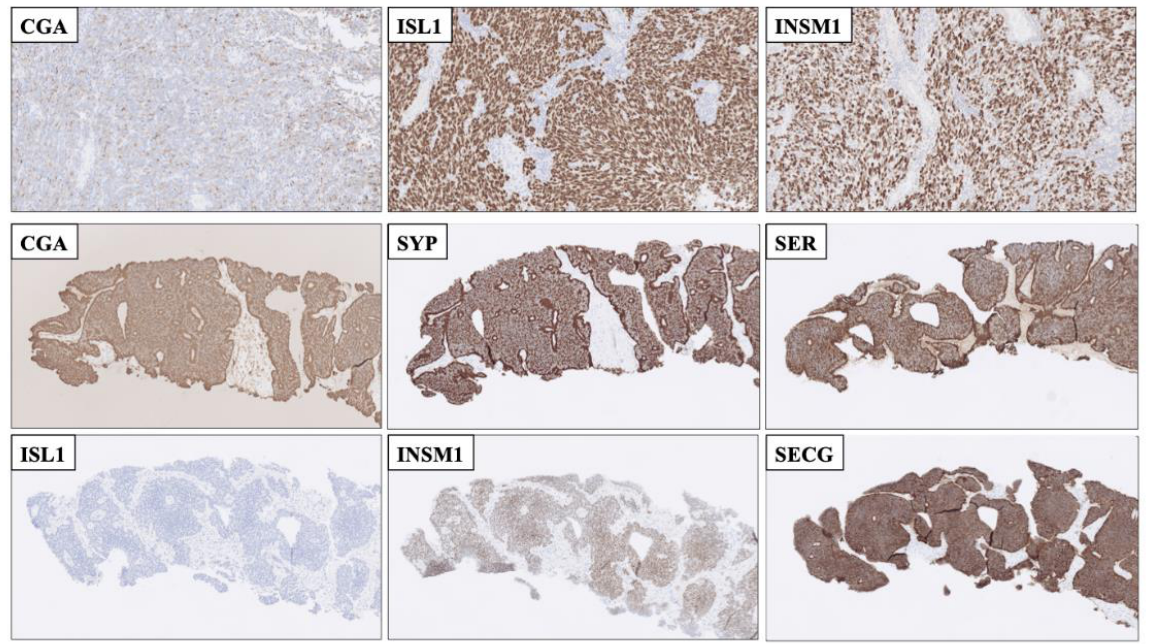
Figure 3. Immunohistochemical stainings displaying advantages of employing second-generation neuroendocrine markers compared to using first-generation markers alone. Top row: Resected cerebellar metastasis of a poorly differentiated neuroendocrine carcinoma (NEC) of unknown primary with only focal Chromogranin A (CGA) staining. The metastasis was diffusely positive for nuclear ISL LIM Homeobox 1 (ISL1) and INSM Transcriptional Repressor 1 (INSM1), Thus, the second-generation markers helped pinpoint this lesion as neuroendocrine. Middle and bottom rows: Core needle biopsy of a well-differentiated neuroendocrine tumor, metastatic to liver. First-generation CGA and Synaptophysin (SYP) were both positive, as was serotonin, but the second-generation marker ISL1 was negative, adjoined by INSM1 and SEGC positivity. This profile (ISL negative, INSM1 and SECG positive) is indicative of a small-intestinal neuroendocrine tumor, which was subsequently found on imaging.